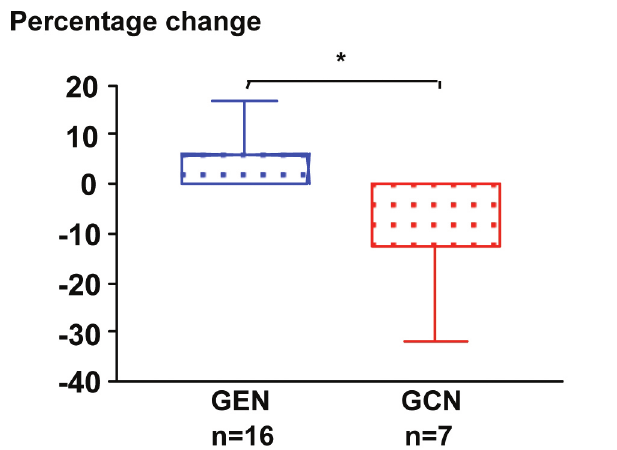
FIGURE 4 - Percentage change ± SD of tryacylglicerol between time 0 and 270 (days) in the experimental group (EGT) and total control group (CGT). *p<0.05. EGT n=18 (18 patients of the total experimental group attended the required exam sessions). CGT n= 15 (15 patients of the total control group attended the required exam sessions).